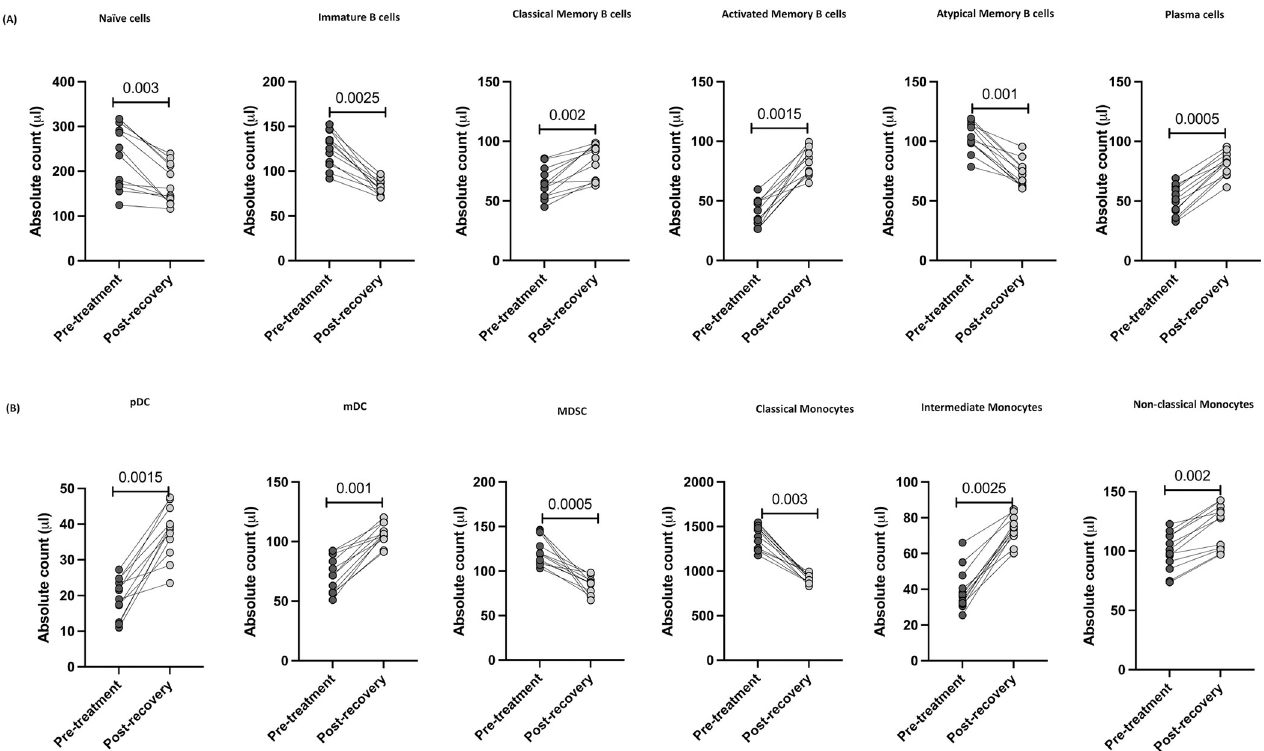
Fig 5. B cell, DC and monocyte subsets were altered post-recovery in MIS-C. (A) Absolute numbers of B cell subsets in MIS-C children (n = 12) at pre- treatment and post-recovery were determined. (B) Absolute numbers of DC and Monocyte subsets in MIS-C children (n = 12) at pre-treatment and post- recovery were determined. p values were calculated using the Wilcoxon matched pair